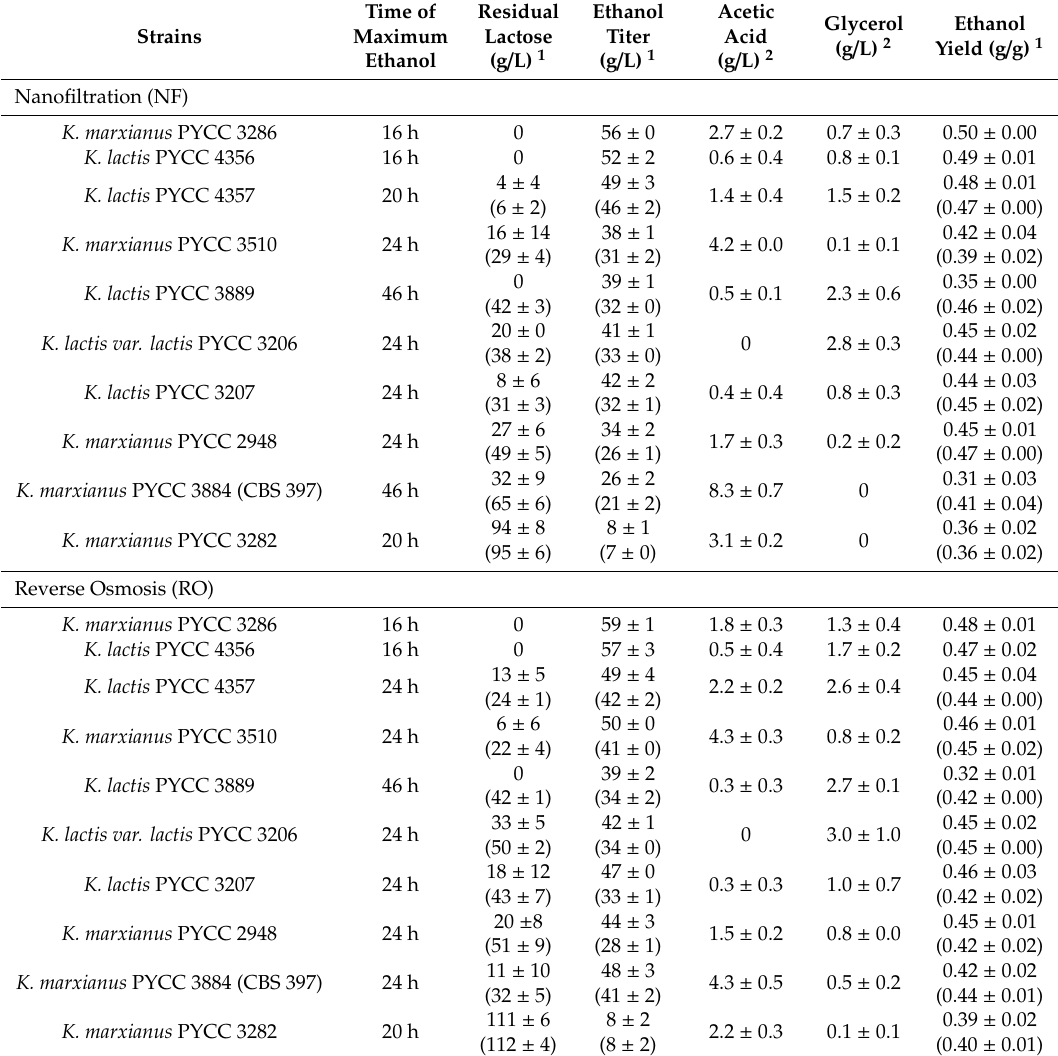
Table 4. Fermentation parameters in the NF and RO retentates under mild oxygen-limiting conditions. Average values of three independent experiments with corresponding standard